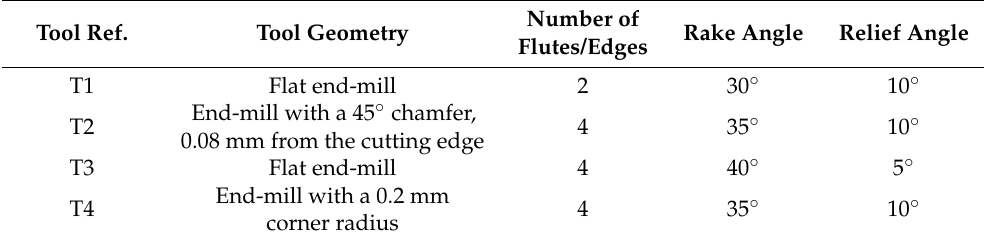
Table 1. Tools created for the machining of UNS S32101. Tool